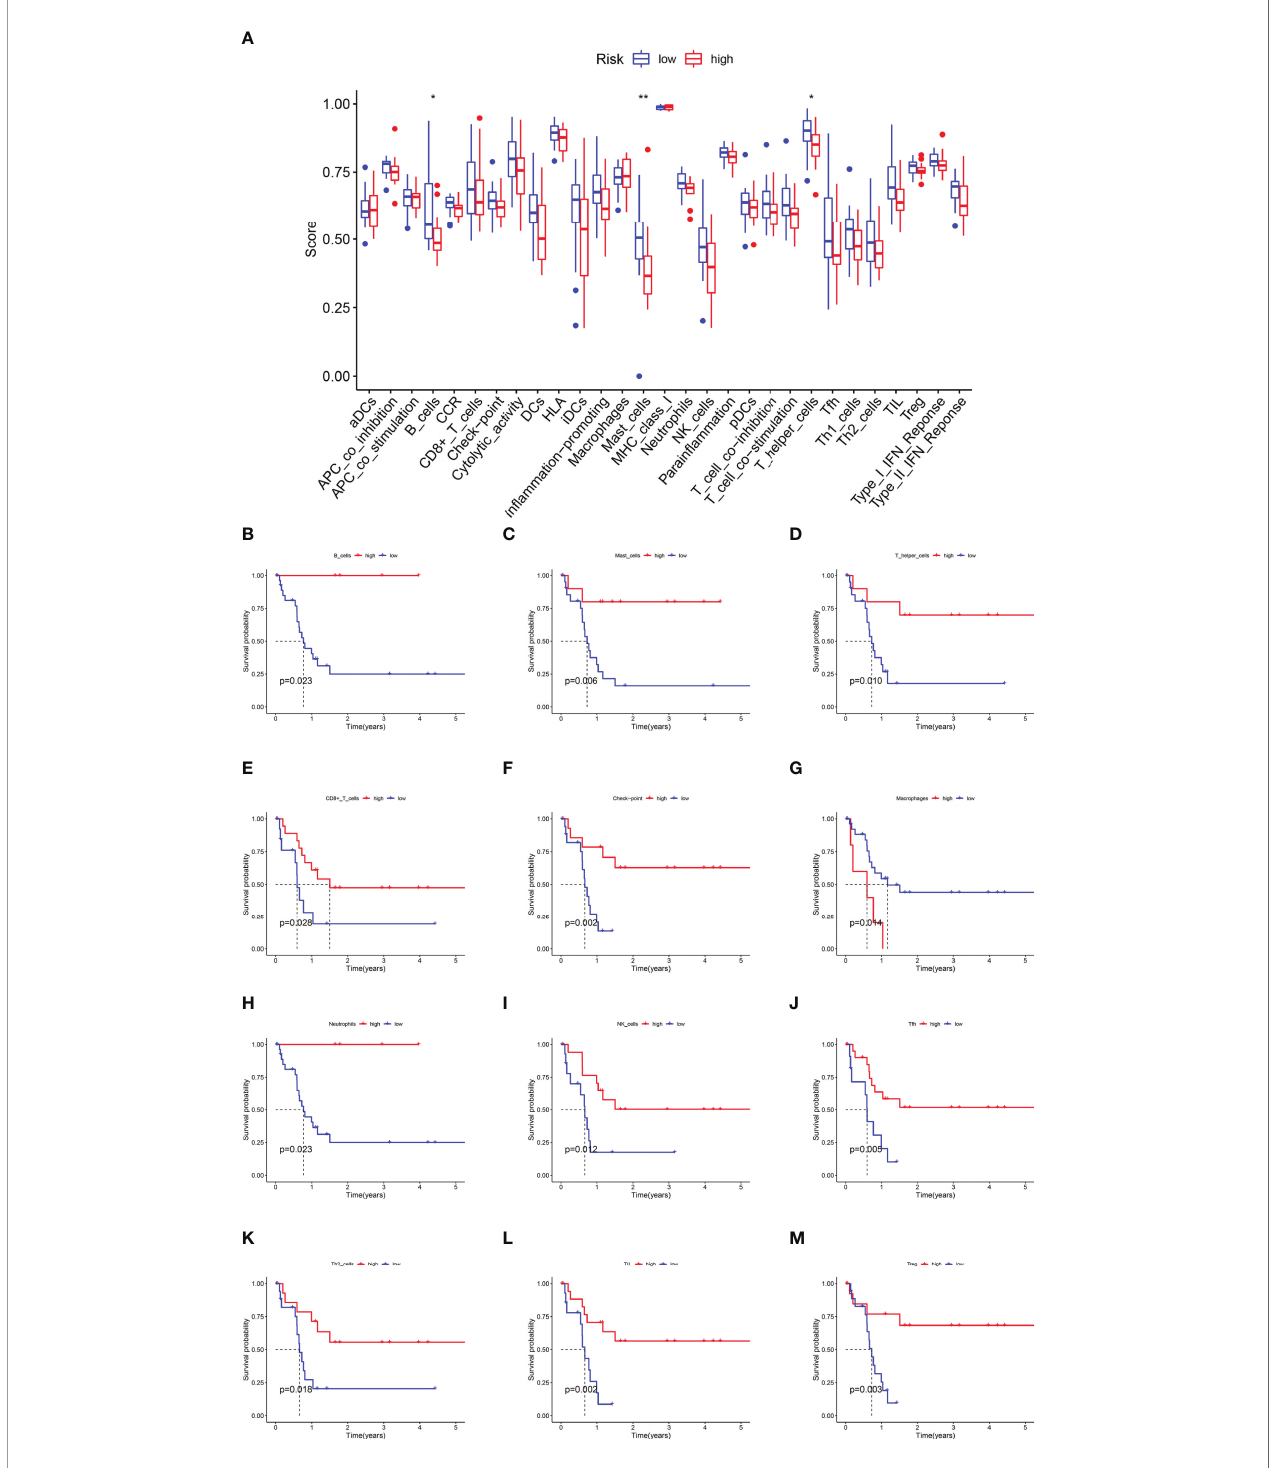
FIGURE 6 | The Kaplan – Meier survival analysis for immune functions. (A) The difference of immune functions between the high-risk and low-risk subgroups. (B) The KM curve of B cells. (C) The KM curve of Mast cells. (D) The KM curve of T helper cells. (E) The KM curve of CD8+T cells. (F) The KM curve of the checkpoint. (G) The KM curve of Macrophages. (H) The KM curve of Neutrophils. (I) The KM curve of NK cells. (J) The KM curve of Tfh cells. (K) The KM curve of Th2 cells. (L) The KM curve of TIL. (M) The KM curve of Treg (* p < 0.05, ** p <